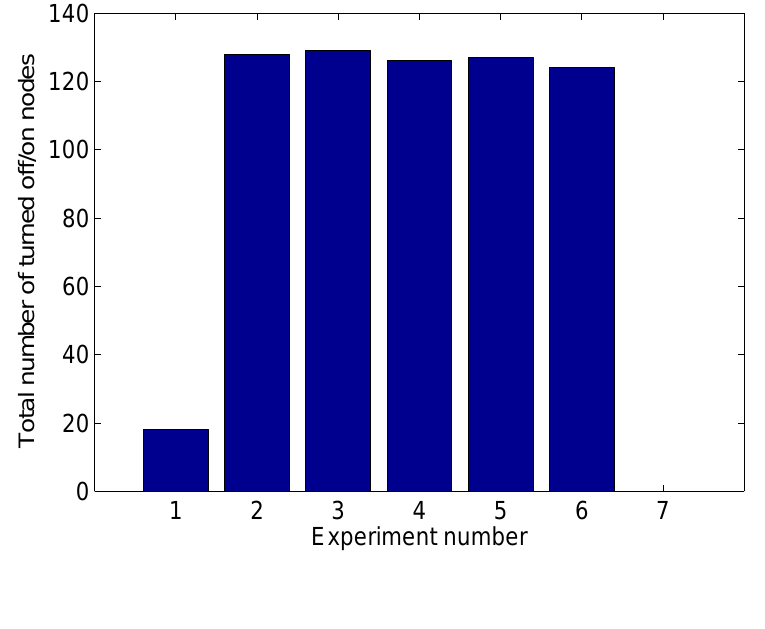
Figure 6. Total number of times that nodes were turned OFF/ON during each